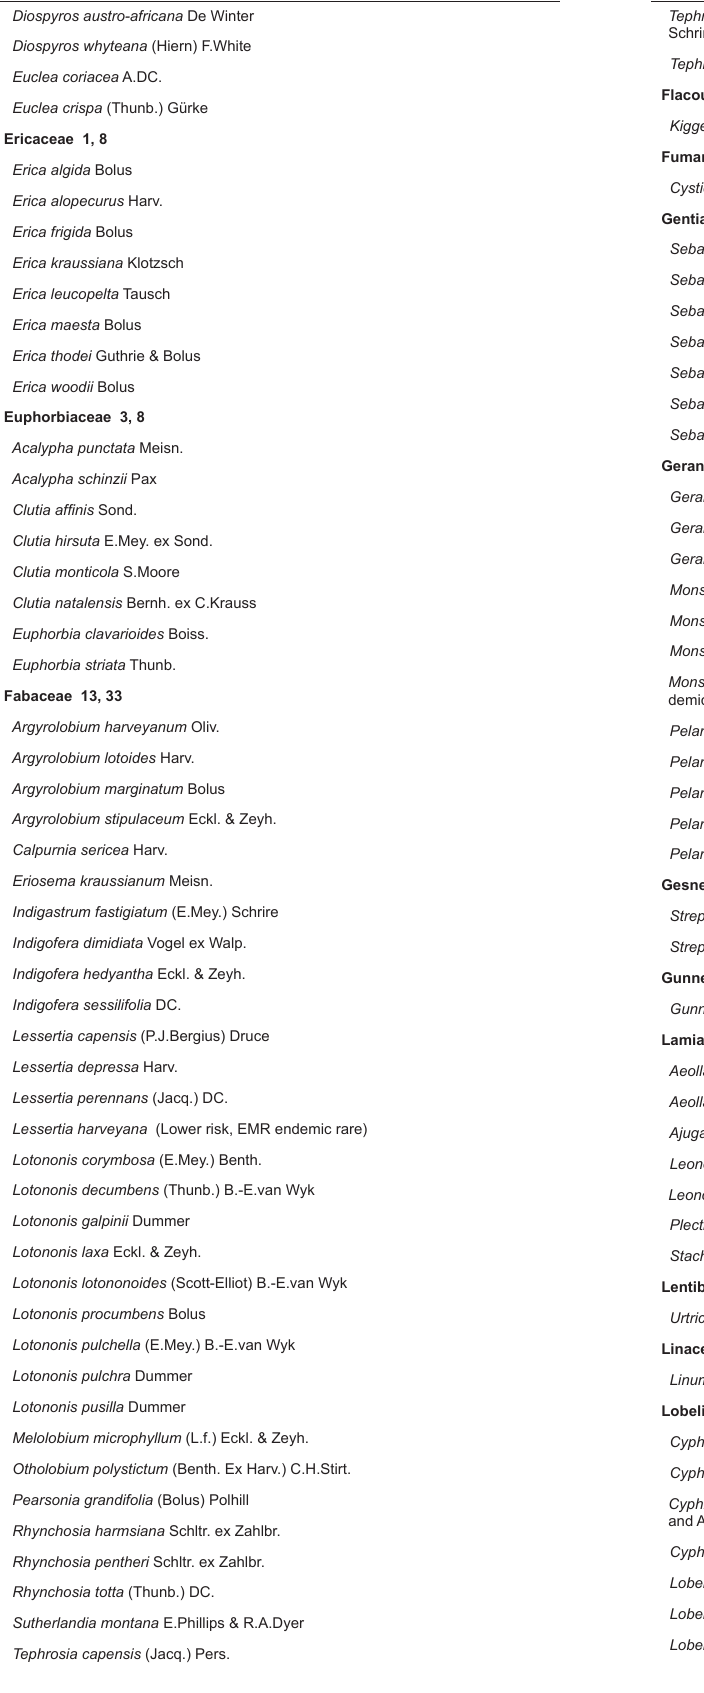
Plant Species Plant